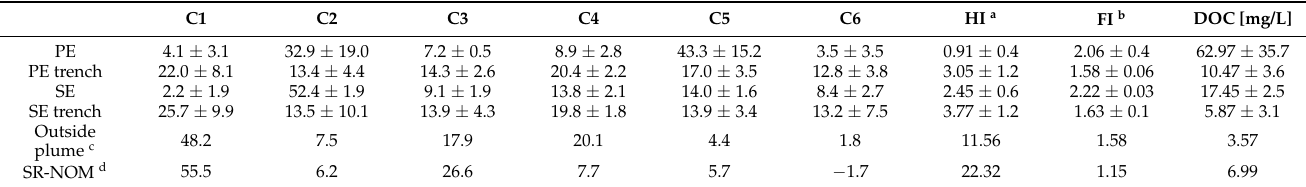
Table 2. Average contribution [%] of the PARAFAC model compounds C1–C6, fluorometric indices and dissolved organic carbon (DOC) for effluent (PE = primary effluent, SE = secondary effluent) and percolation trench samples taken from both study sites in February and March 2017.